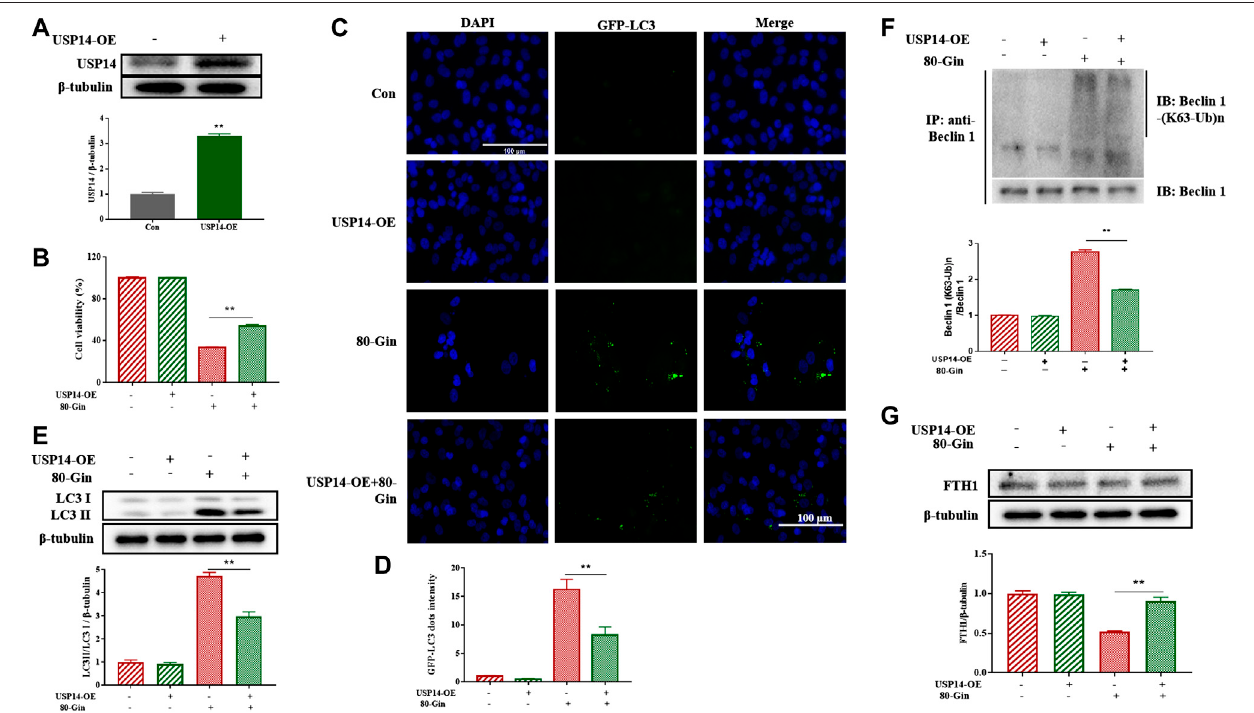
FIGURE 7 | 6-Gingerol up-regulates the expression of LC3 and FTH1 in USP14-OE cells. (A) The western blot analysis of USP14 overexpression; (B) The cell viabilityofUSP14-OE cells treatedwith 6-Gingerol; (C) Therepresentative images ofGFP-LC3and DAPI; (D) The quantitative positiverateofGFP-LC3; (E) Thewestern blotanalysisofFTH1inUSP14-OEcells; (F) ThewesternblotanalysisofLC3inUSP14-OEcells; (G) TheCo-IPanalysisofubiquitinationofK63onBeclinoneinUSP14- OE cells. Data are expressed as mean ± SD, * p < 0.05, ** p < 0.01 ( n (cid:2) 3).